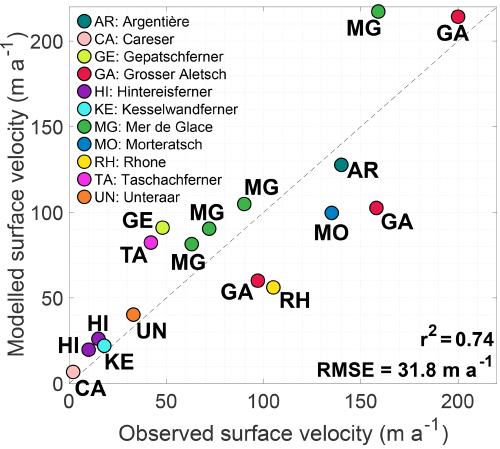
Figure 6. Observed vs. modelled surface velocities for selected glaciers in the European Alps. For some glaciers several data points exist, consisting of different locations on the glacier. More infor- mation concerning the surface velocities and corresponding refer- ences is given in the Supplement (Table S2). For glacier location, see Fig.